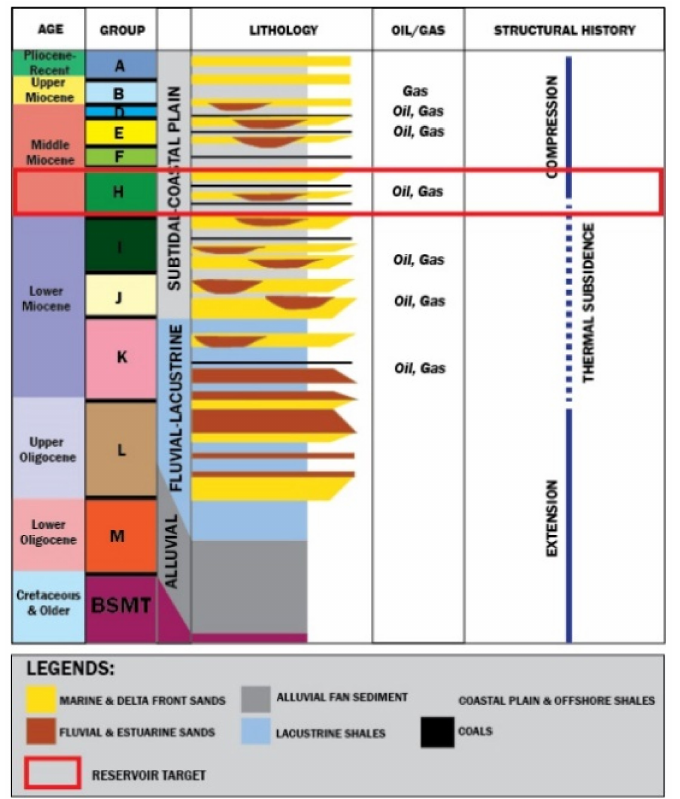
Figure 3. Regional stratigraphic column of the Malay Basin and the reservoir target which is highlighted by a red rectangle. The study is focused on a reservoir target in Group H (modified from